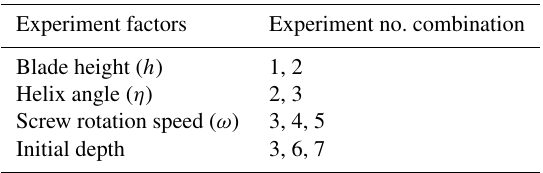
Figure 10. When t = 0 . 27s, the screw transport drum transfers par- ticles.